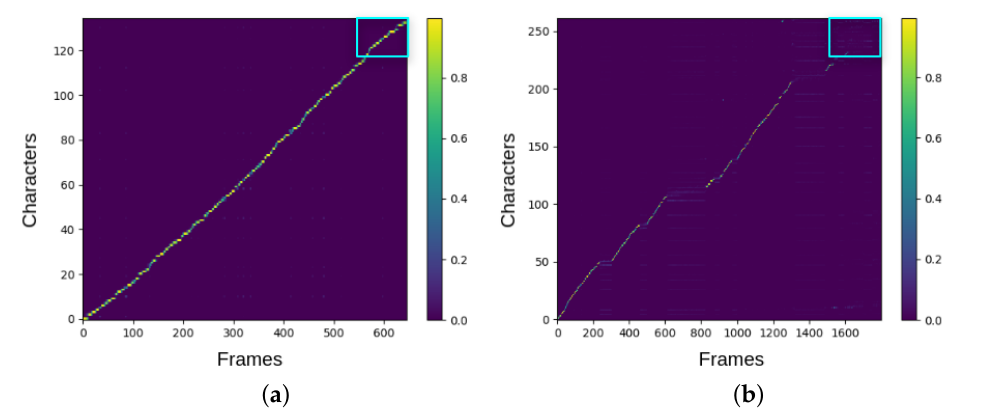
Figure 4. Alignment of two different sentences and inspection area of the error detection algorithm: ( a ) correctly aligned sentence; ( b ) incorrectly aligned